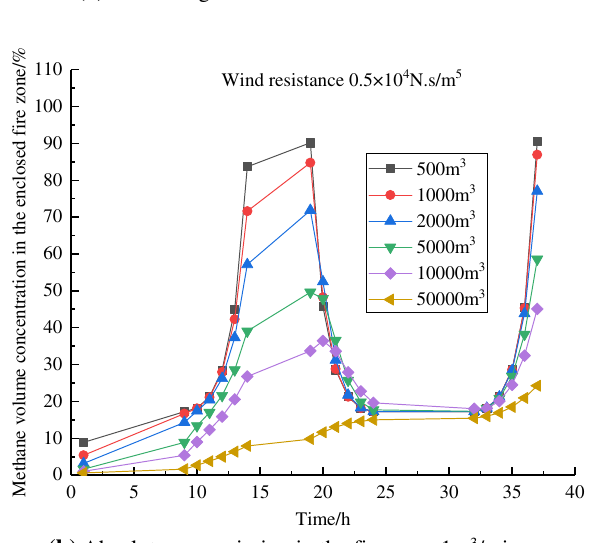
(a) Absolute gas emission in the fire zone 10m 3 /min